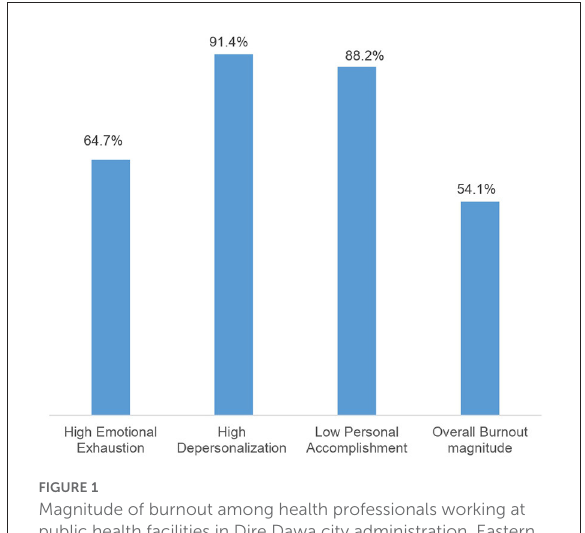
FIGURE1 Magnitude of burnout among health professionals working at public health facilities in Dire Dawa city administration, Eastern Ethiopia 2020 ( n =